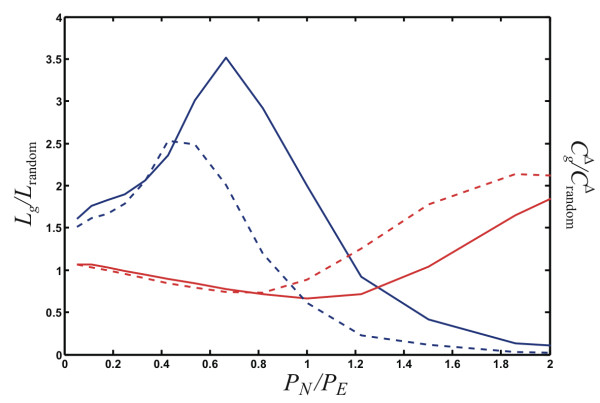
Normalized mean shortest path and correlation coefficient. The normalized mean shortest path between nodes, Lg/Lrandom (red lines) and the normalized correlation coefficient  (blue lines) as a function of the ratio PN/PE, for a node duplication probability p = 1 and two different edge addition probabilities q = 0.75 (dashed) and q = 1 (solid). Average over 1,000 networks grown to 200 nodes, with PD = 0.